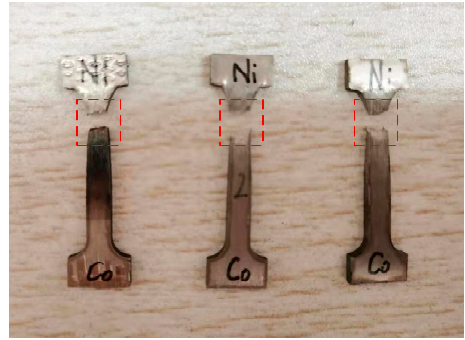
Figure 10. Fracture location of the tensile specimens.